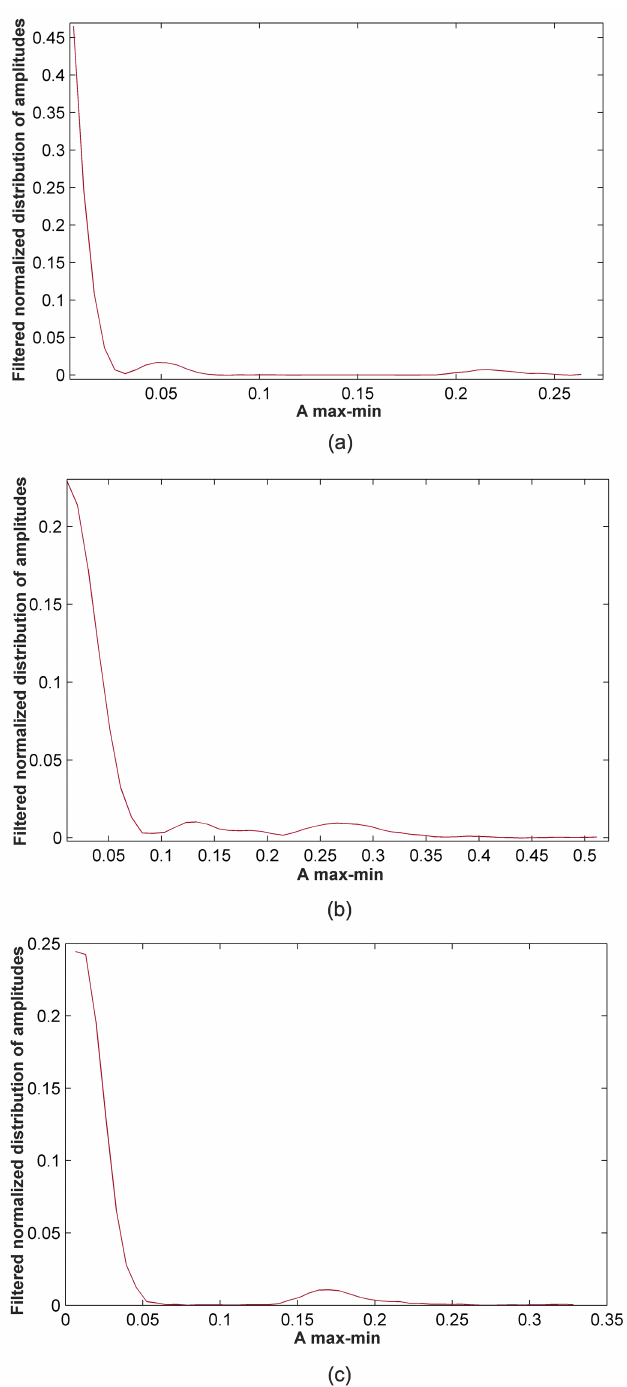
Fig 4. Example of feature selection using the filtered normalized distribution of amplitudes. (a) Case 1: selection of amplitude (50,000-sample window of r07 Ab-4 denoised recording) (b) Case 2: selection of amplitude multiplied by the number of samples (50,000-sample window of r01 Ab-4 denoised recording) (c) Case 3: selection of amplitude multiplied by the number samples (50,000-sample window of r08 Ab-4 denoised recording).